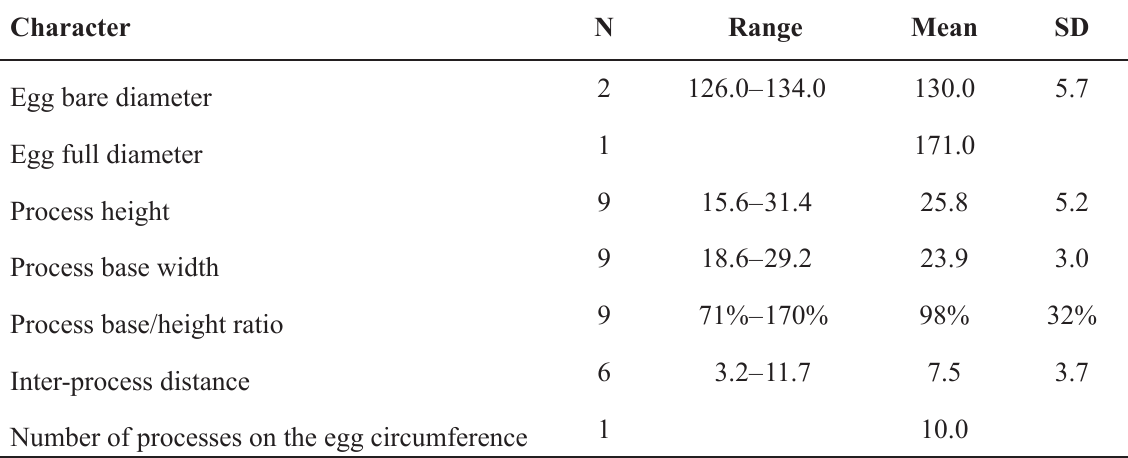
Table 3. Measurements (in μm) of selected morphological structures of the eggs of Sisubiotus hakaiensis sp. nov. mounted in Hoyer’s medium. Abbreviations: N = number of eggs/structures measured; Range = the smallest and the largest structure among all measured specimens; SD = standard